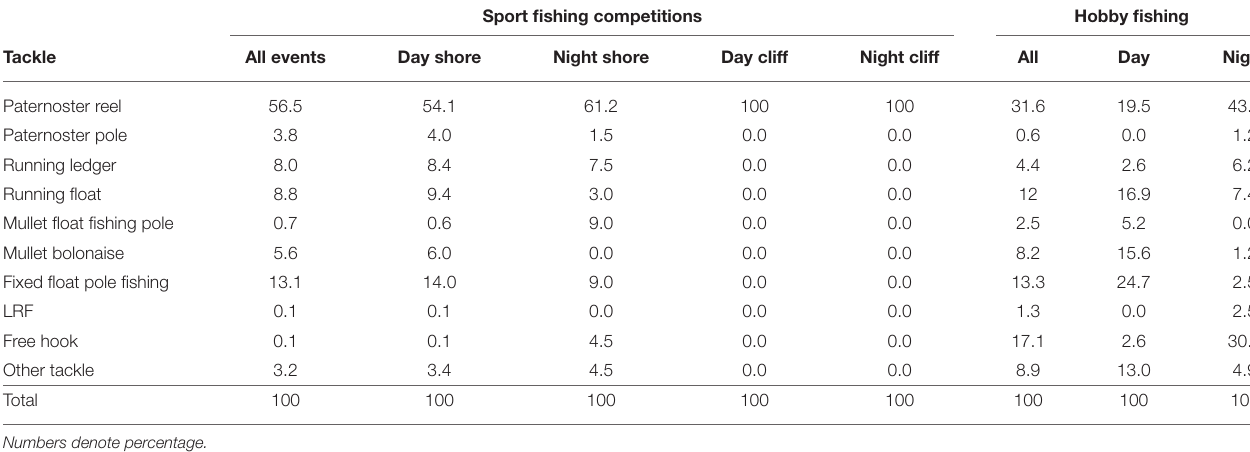
TABLE 1 | Tackle used during fishing competitions and hobby fishing.